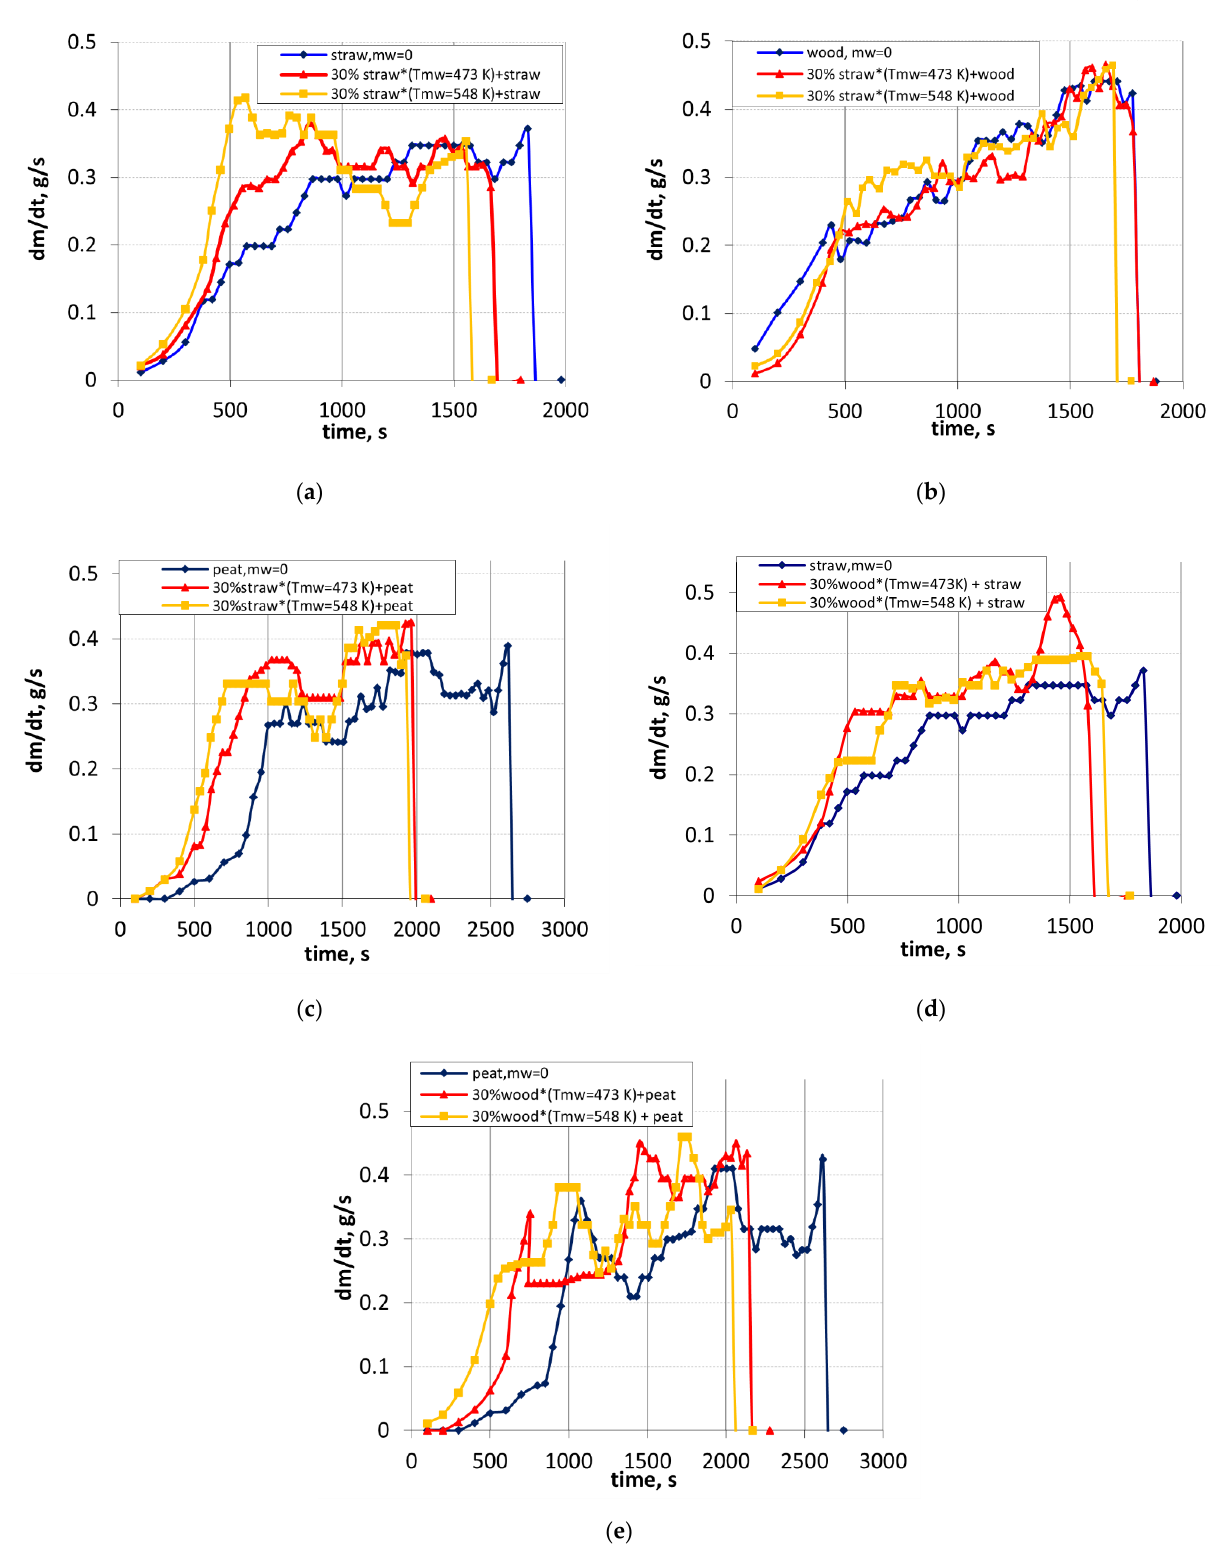
Figure 3. MW pre-treatment temperature effect on the weight loss rate for different blends ( a – e ) with fixed fraction of pre-treated pellets (30%).